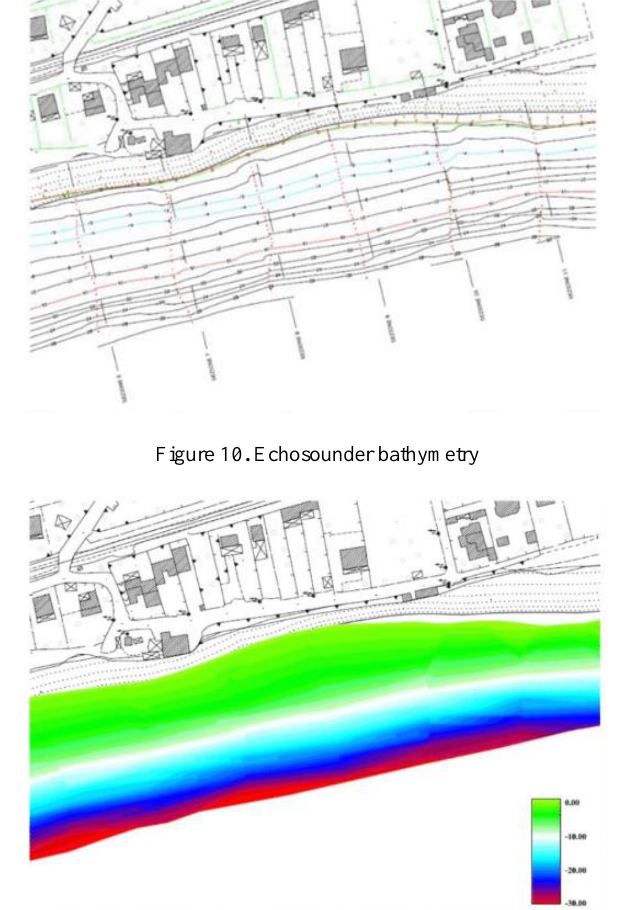
Figure 11 . 3D Model Bathymetry (overlapping between isoipse and depths contours)